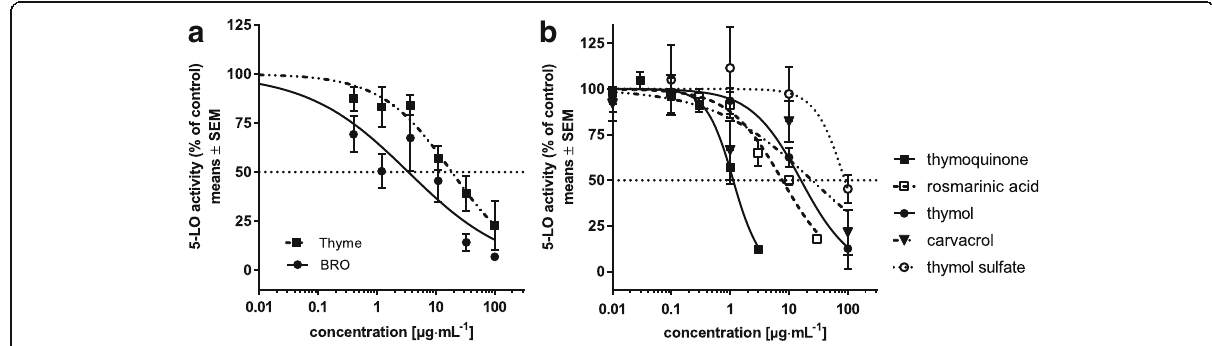
Fig. 4 Inhibition of purified human recombinant 5-LO enzyme activity by ( a ) BRO and thyme extract and ( b ) the single compounds thymol, thymol sulfate, carvacrol, thymoquinone and rosmarinic acid. Data shown are means ± SEM; n =3 – 4 (individual experiments). Basal 5-LO product formation (100% control) was 643±325.3 μ g ∙ μ L − 1